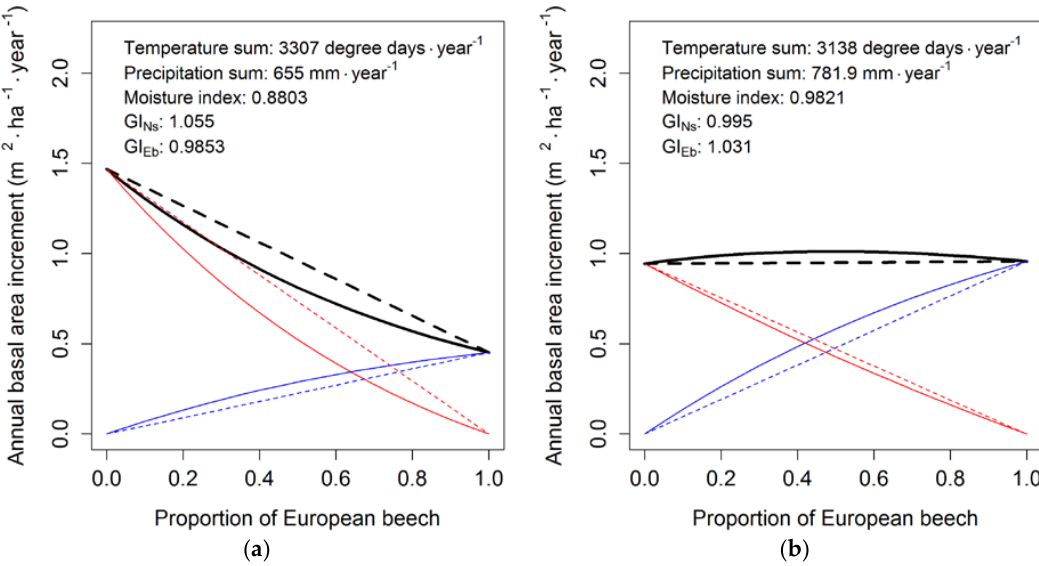
Figure 5. Basal area increment of two NFI sites using 3P proportions: ( a ) the site showing the lowest underyielding for 50%–50% proportions; and ( b ) a site showing a transgressive overyielding. The basal area increment was predicted for Dg = 35 cm, sd = 0.65 and the ecological conditions indicated on the respective graphs for European beech (blue), Norway spruce (red) and the total stand (black). Underyielding (or overyielding) is the negative (or positive) difference between the predicted basal area increment in mixture (continuous line) and the expected increment under the assumption of no mixing effects (dashed line). GI Ns : growth index for Norway spruce.